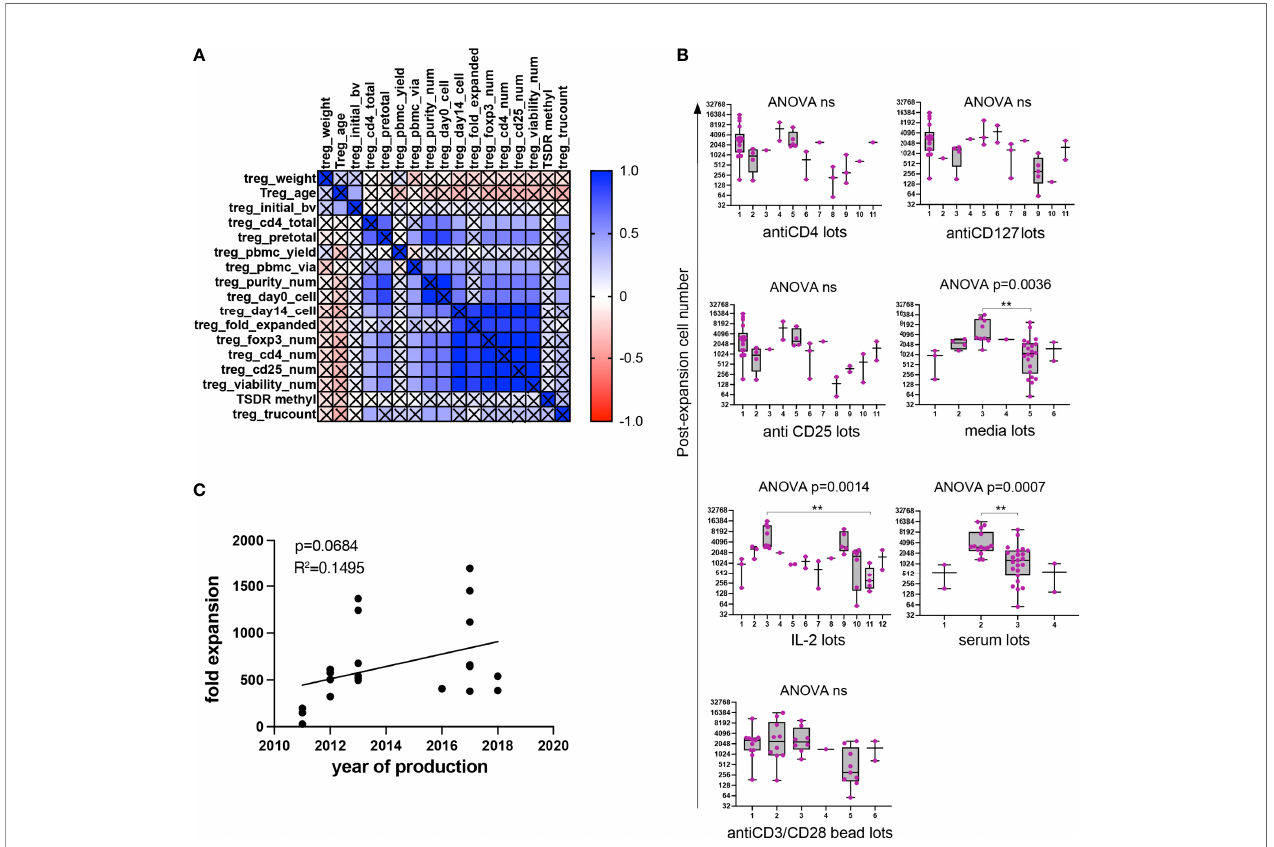
FIGURE 6 | Unbiased correlation analyses. Unbiased correlation analysis of all continuous variables (A) . Pseudocolor; red represents negative correlation, blue represents positive correlation. Intensity of color is proportional to size of correlation. Signi fi cance threshold set at p=0.01. Black cross over cell represents nonsigni fi cant correlation. Analysis of impact by categorical variable (material lots) on post-expansion cell number (B) . In box and whisker plots, the box shows mean and quartiles, whiskers show minimum and maximum values. Fold expansion by year of production among DM1 patients (n=22) (C) . R squared (R 2 ) values and p- value assess goodness of fi t, and signi fi cance of slope not equal to zero. In box and whisker plots, the box shows mean and quartiles, whiskers show minimum and maximum values. **p < 0.01. ns, not signi fi